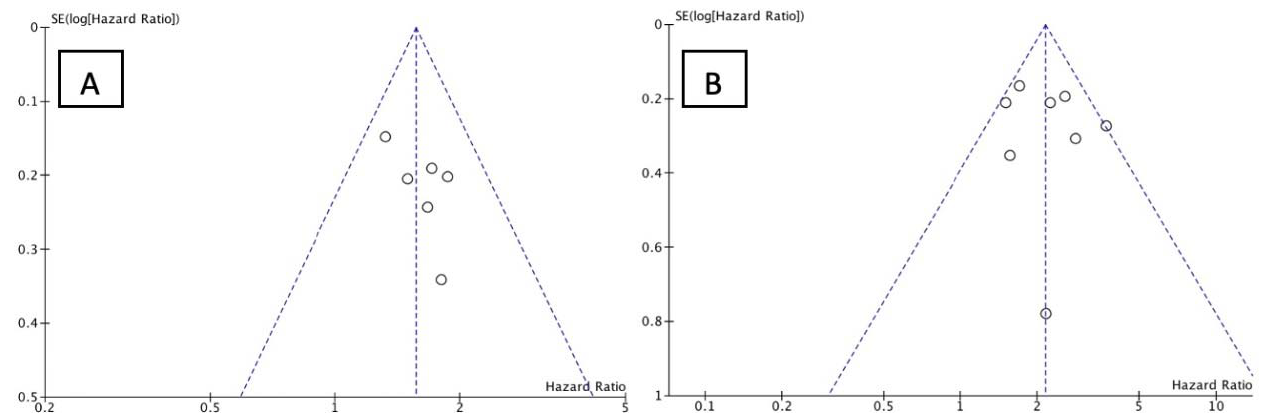
Figure 7. Funnel plot of PLR ( A ) PFS and ( B ) OS. The small circle represent individual study.